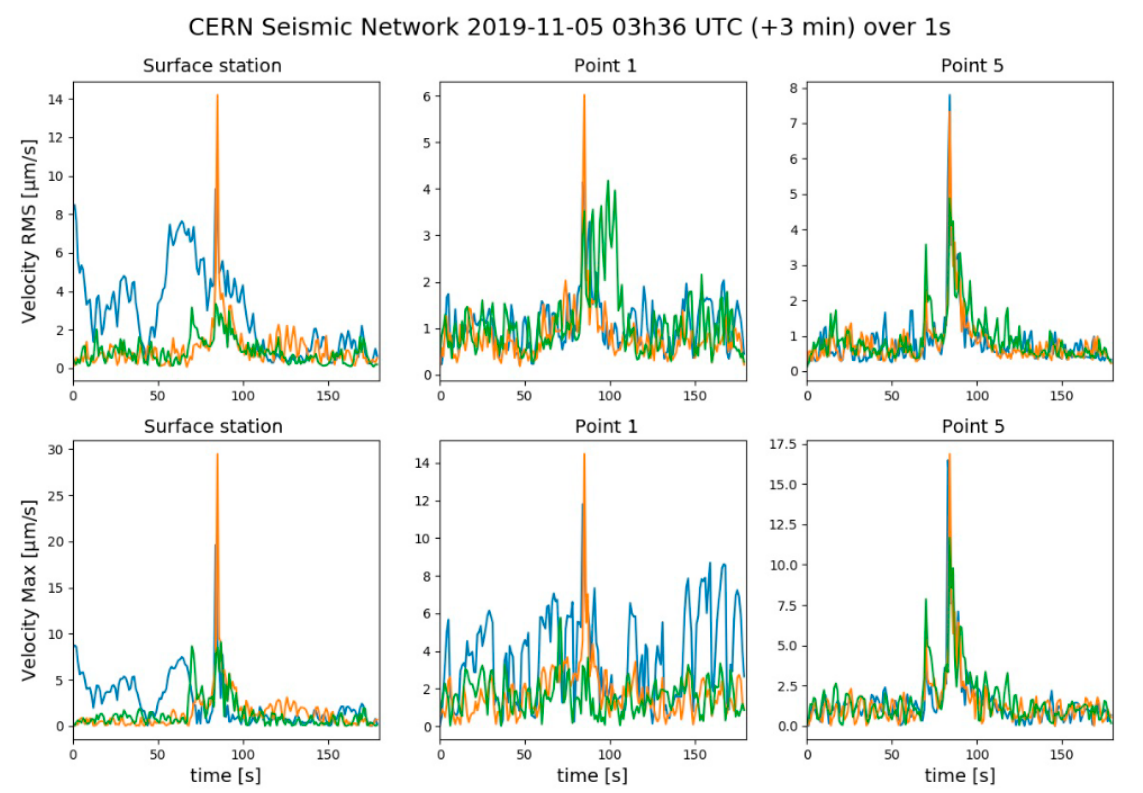
Figure 9. Velocity RMS data plot registered by three CERN seismic stations between 03:36 and 03:39 (UTC) on 6 November 2019.